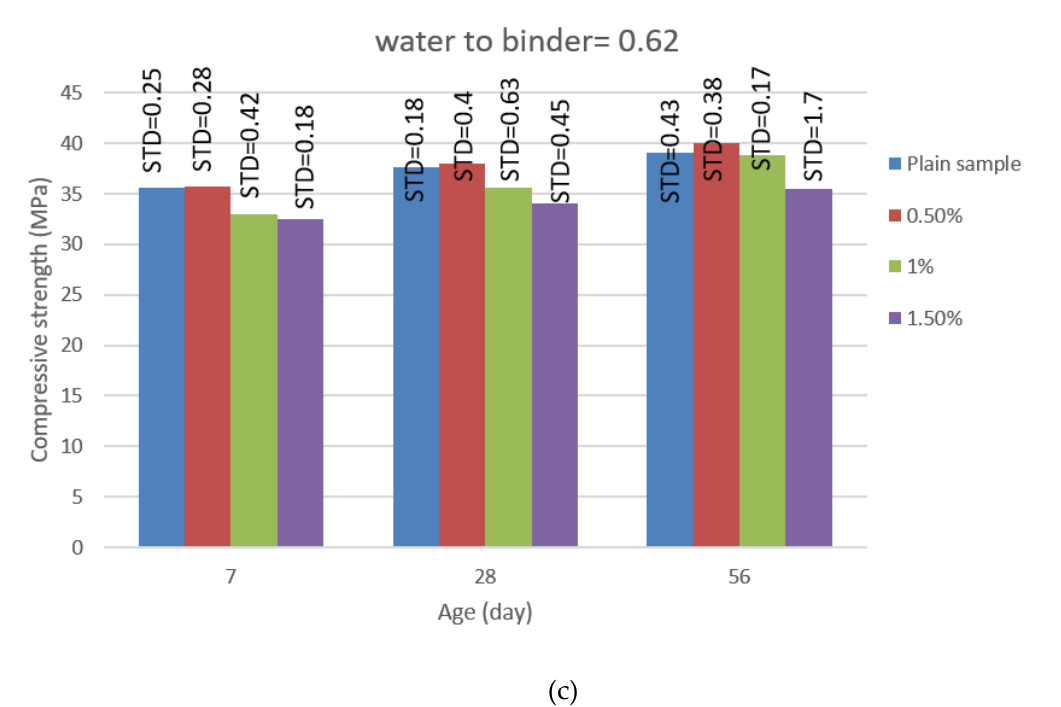
Figure 8. Compressive strength vs. age of concrete for water-to-binder ratios of ( a ) 0.44, ( b ) 0.49, and ( c ) 0.62.